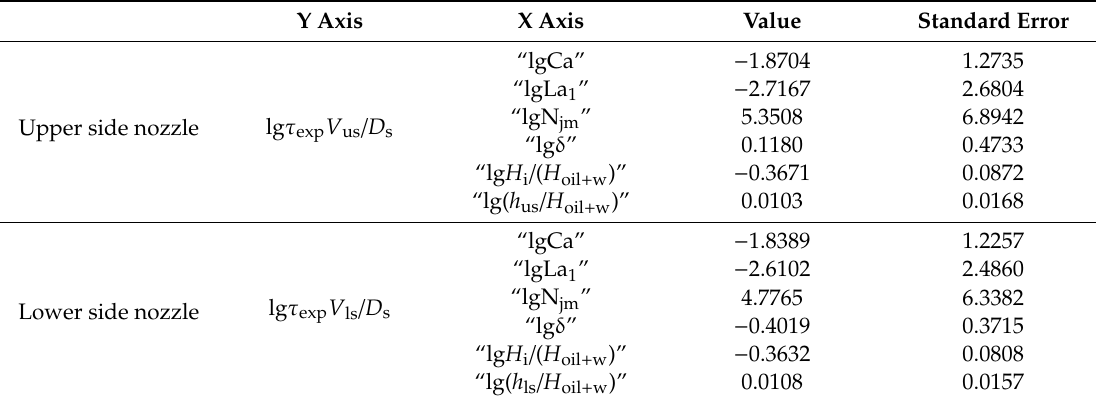
Table 9. Value and standard error of lg Ca, lg La 1 , lg N jm , lg δ , lg H i / ( H oil + w ), and lg( h s / H oil + w ) by multiple linear regression for upper side nozzle and lower side